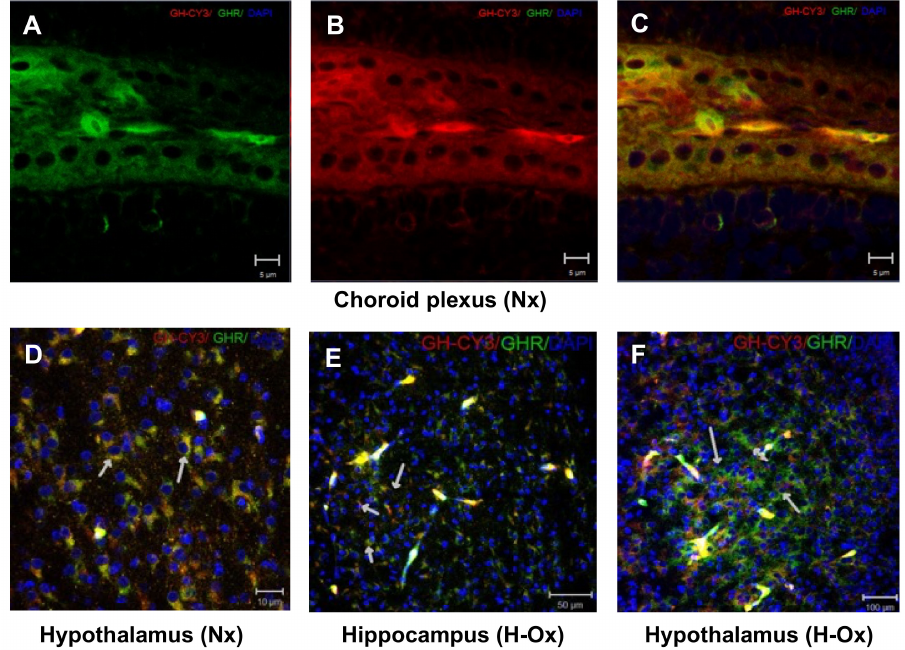
Figure 3. Co-localization of Cy3-GH and GH receptor (GHR)-immunoreactivity in the embryonic chicken brain. Representative immunohistochemical images showing the distribution of ( A ) GHR-IR (green), ( B ) Cy3-GH (red), or ( C ) merge of both (yellow) in the choroid plexus; hypothalamus ( D , E ); and hippocampus ( F ) of animals that were treated with Cy3-GH under either normoxia ( A – D ) or hypoxia conditions ( E , F ). The yellow regions, indicated by arrows, show the co-localization of the hormone with its receptor. Cell nuclei were stained with DAPI (blue). Scale bar 5 µ m ( A – C ); 10 µ m in ( D ); 50 µ m in ( E ), and 100 µ m in ( F